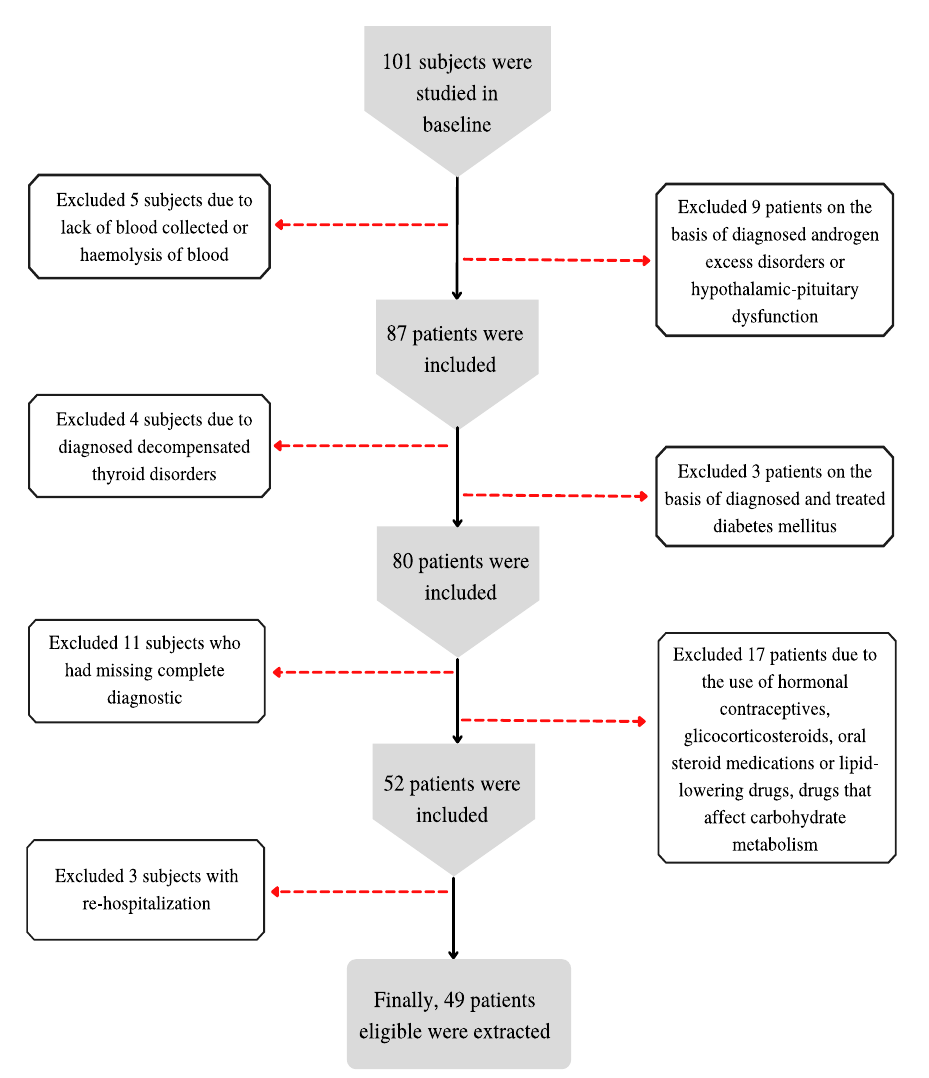
Figure 1. Patient qualification algorithm for the